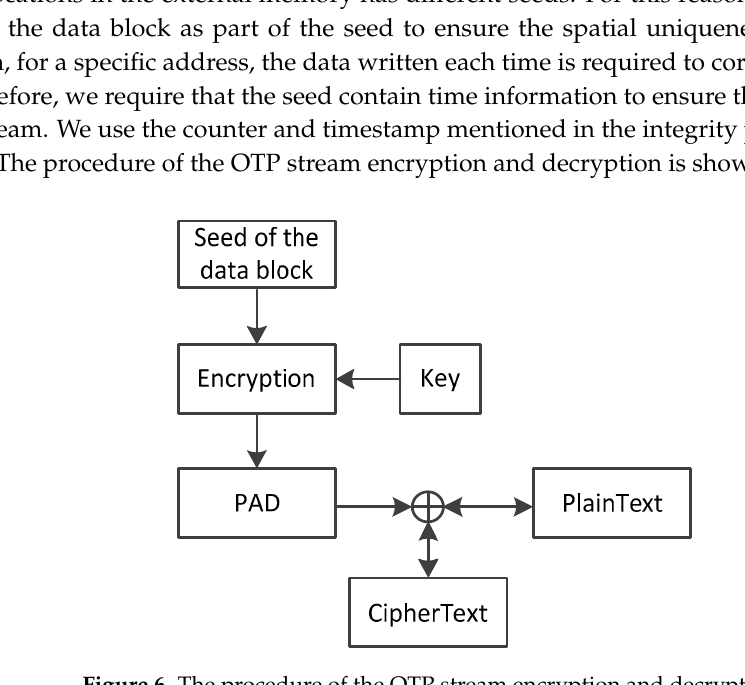
Figure 6. The procedure of the OTP stream encryption and decryption.